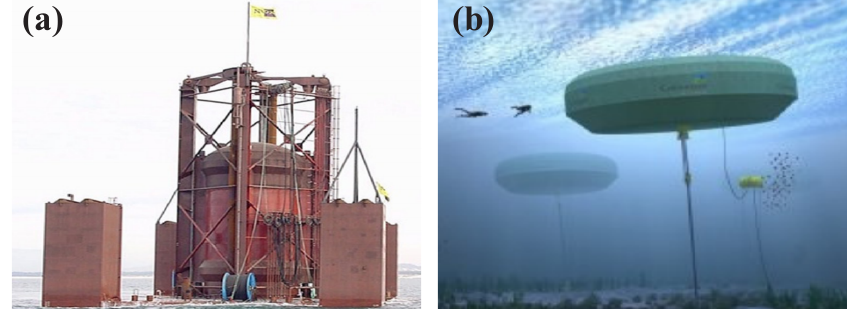
Figure 5. The AWS device [96] and the CETO device [97] are shown as typical examples of submerged one-body PAs in ( a , b ),